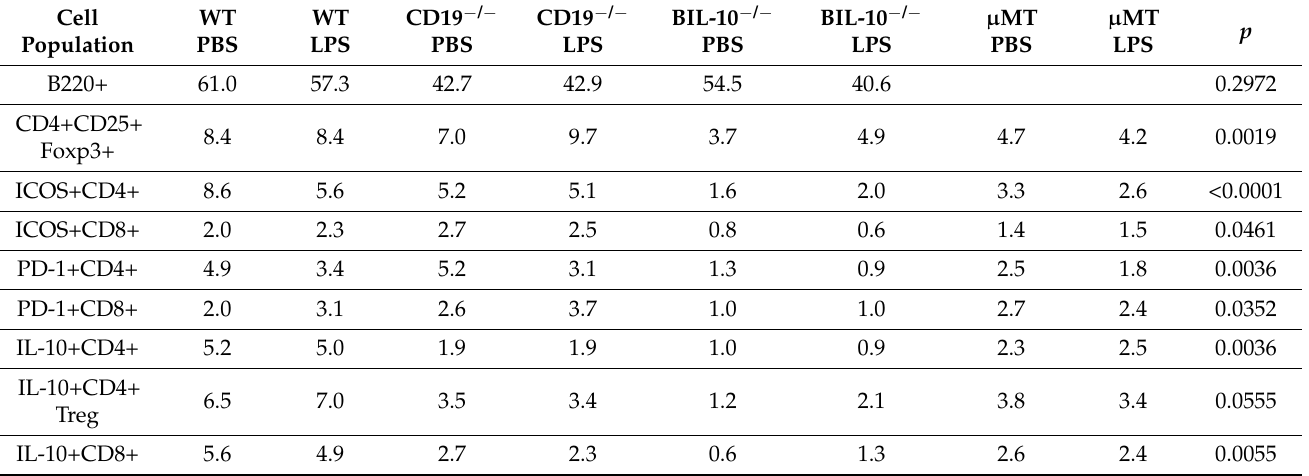
Table 2. Immune cell populations in spleen. Shown are the the mean frequencies of B220+ B cells, ICOS-expressing CD4+ and CD8+ T cells, PD-1-expressing CD4+ and CD8+ T cells as well as IL-10- expressing CD4+, CD4+CD25+Foxp3+ Treg cells and CD8+ T cells in spleen, determined by flow cytometry. N = 4–6 mice/group, the p values were analyzed by One-way ANOVA or Kruskal–Wallis test after Shapiro–Wilk